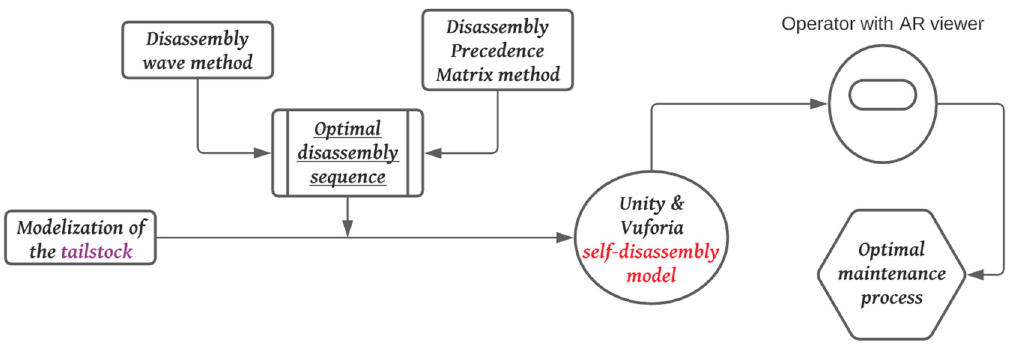
Figure 2. Logical diagram of the work.